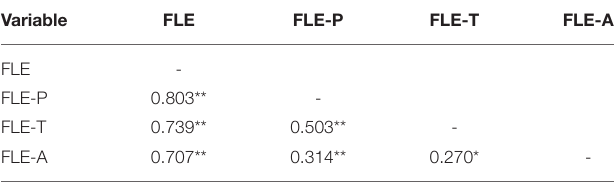
TABLE 4 | Correlations between FLE and its subscales ( N = 90). Variable